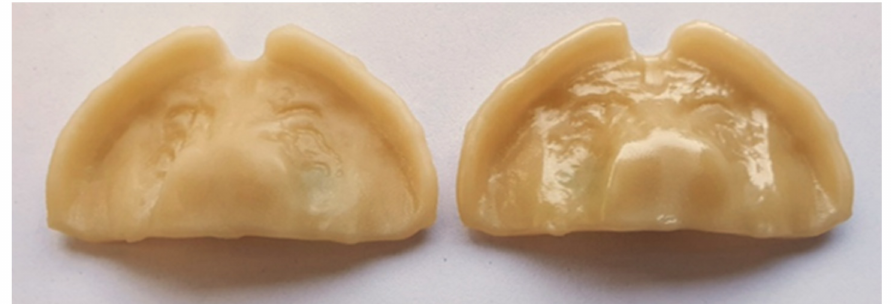
Figure 7. Difference of surface finishing between Yamahachi PMMA blanks after manufacturing. Left: manufacturing after PEEK blanks and used tools. Right: manufacturing with new tools.